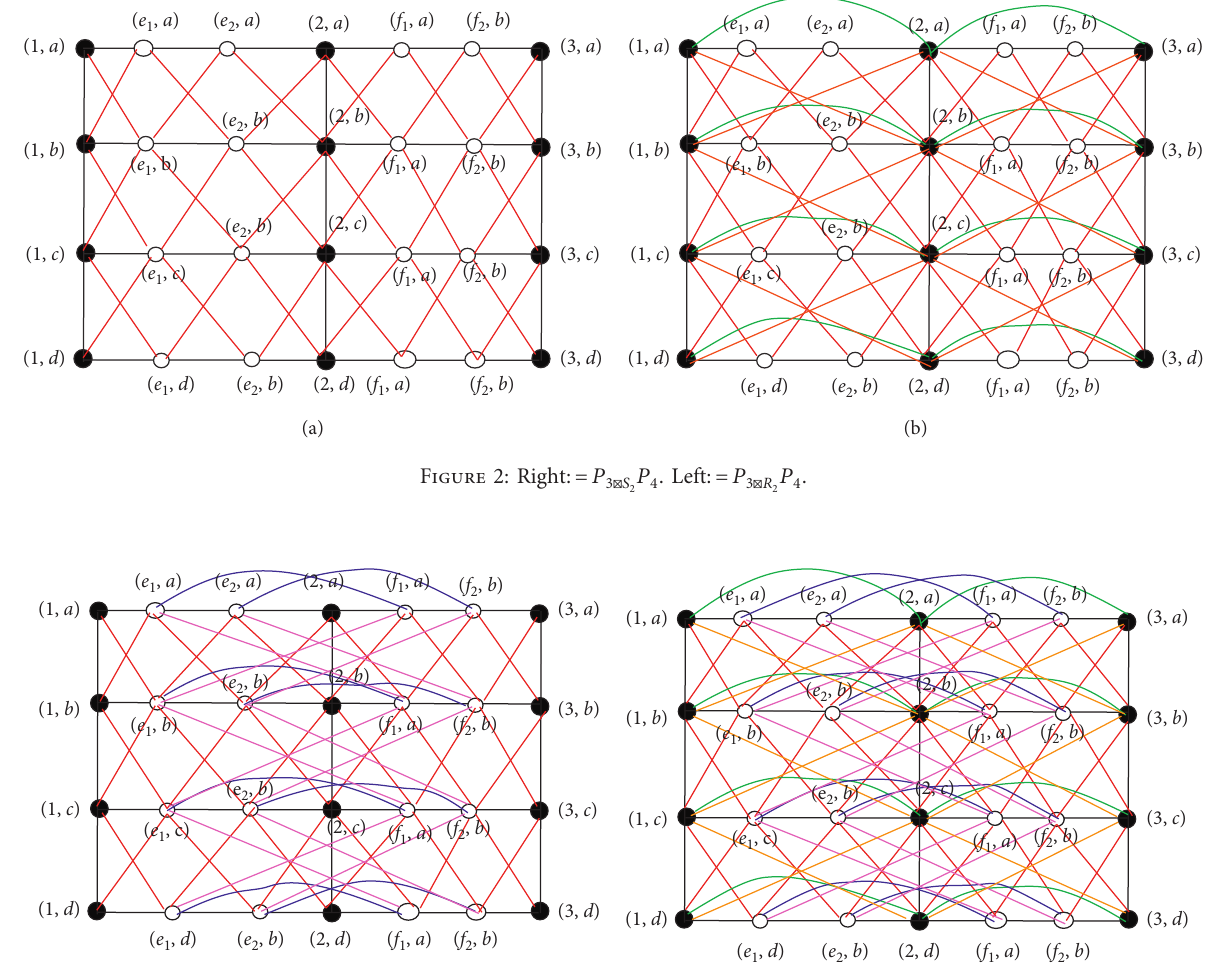
Figure 3: Right: � P